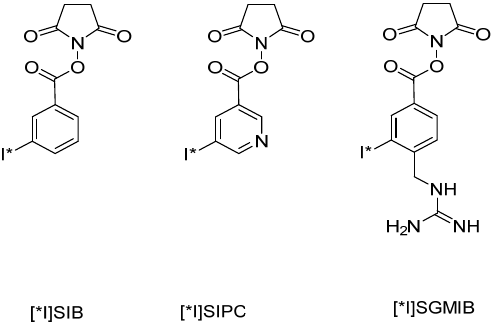
Figure 4. Chemical structures of the chelating agents SIB, SIPC and